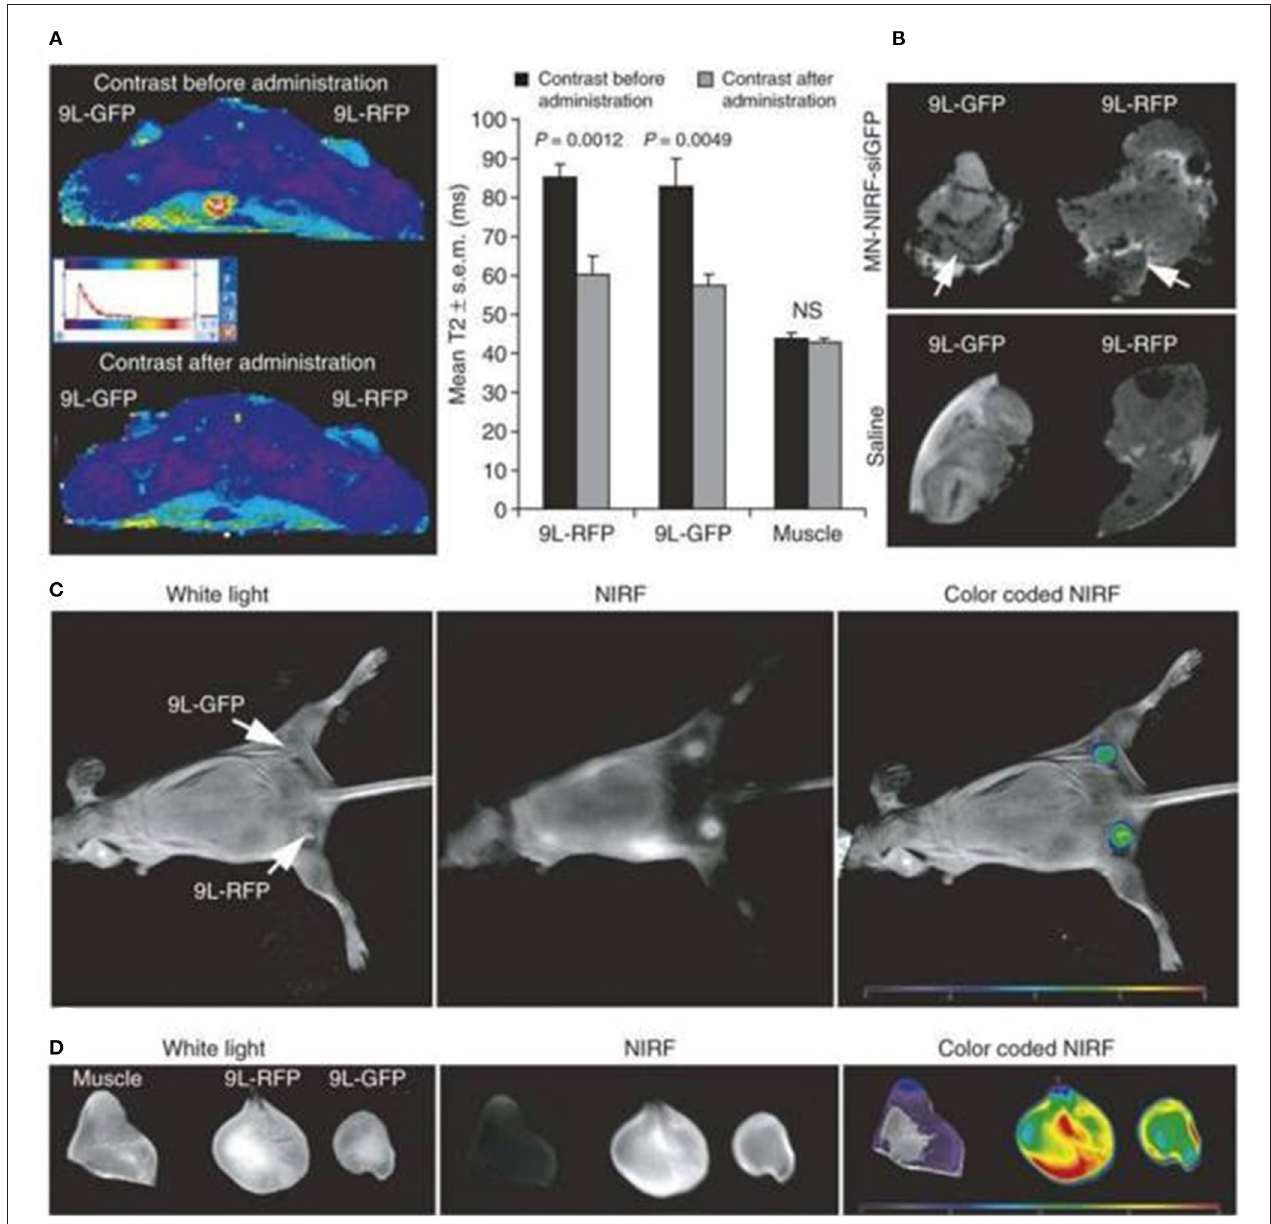
FIGURE 5 | It reveals that in vivo MRI was conducted before and after 24h the administration of nanoparticles (9L-GFP) (9L-RFP) on rats with tumors. (A) After the tumor was injected, T2 relaxation reduced dramatically. It should be noted that the T2 muscle tissue relaxation times have not improved. (B) Ex vivo excised tumor high-resolution RMIs (78m isotropic). Differentiated signal loss (arrows) indicating the concentration of the probe is quickly recognized in tumors that resulted from muzzle-injected controls. (C) The optical in vivo NIR imagery of the same rat showed a tumor-based high-intensity NIR signal. This meant that the tissue had